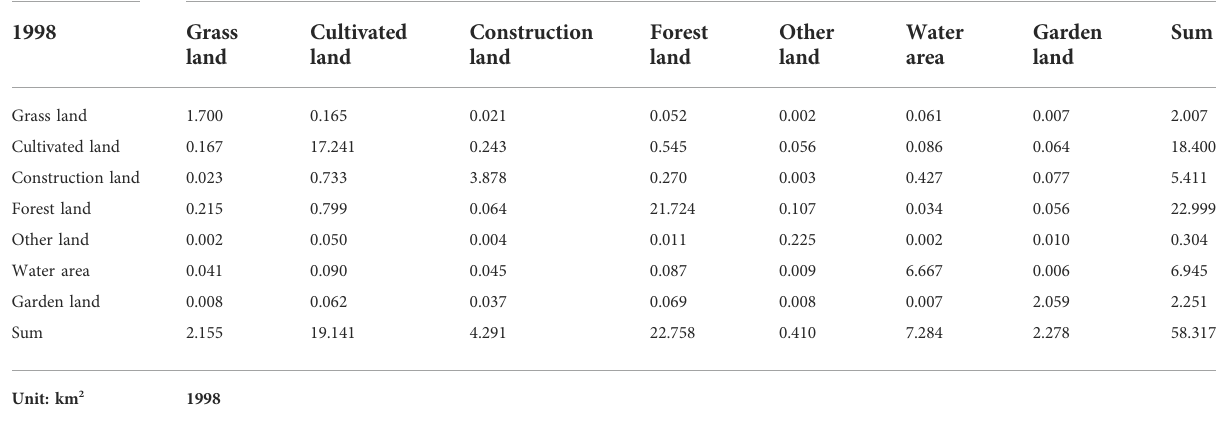
TABLE 3 Transfer matrix of land-use area in Jinshitan (1988 – 2019). Unit: km